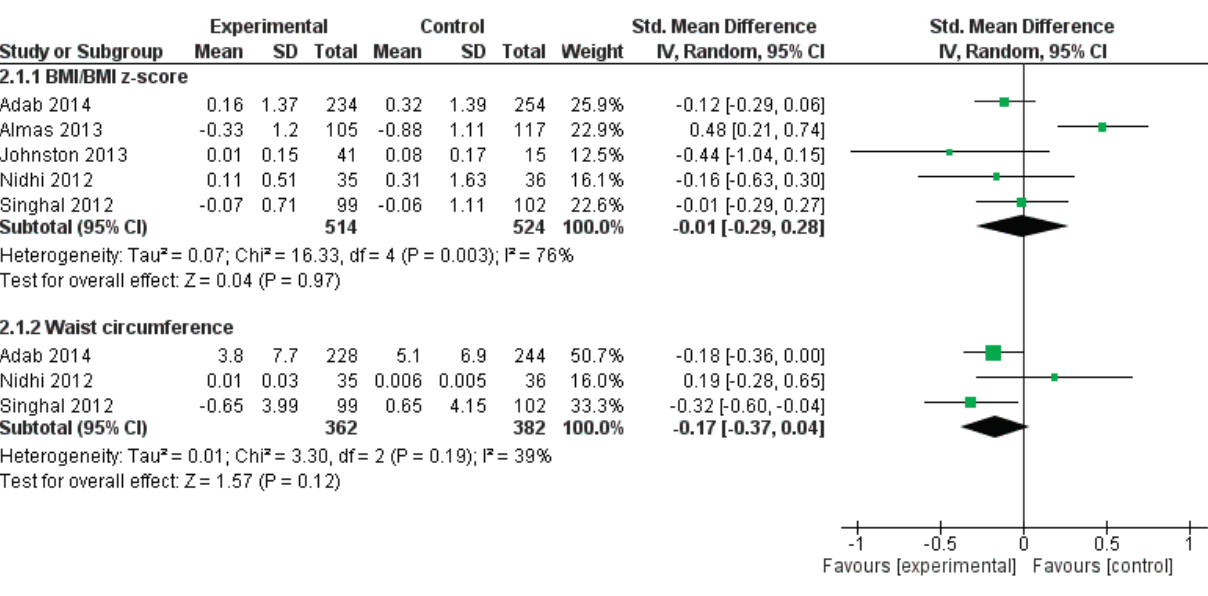
Figure 2. Meta-analyses of mean change in obesity outcomes from baseline to post-intervention for South Asian